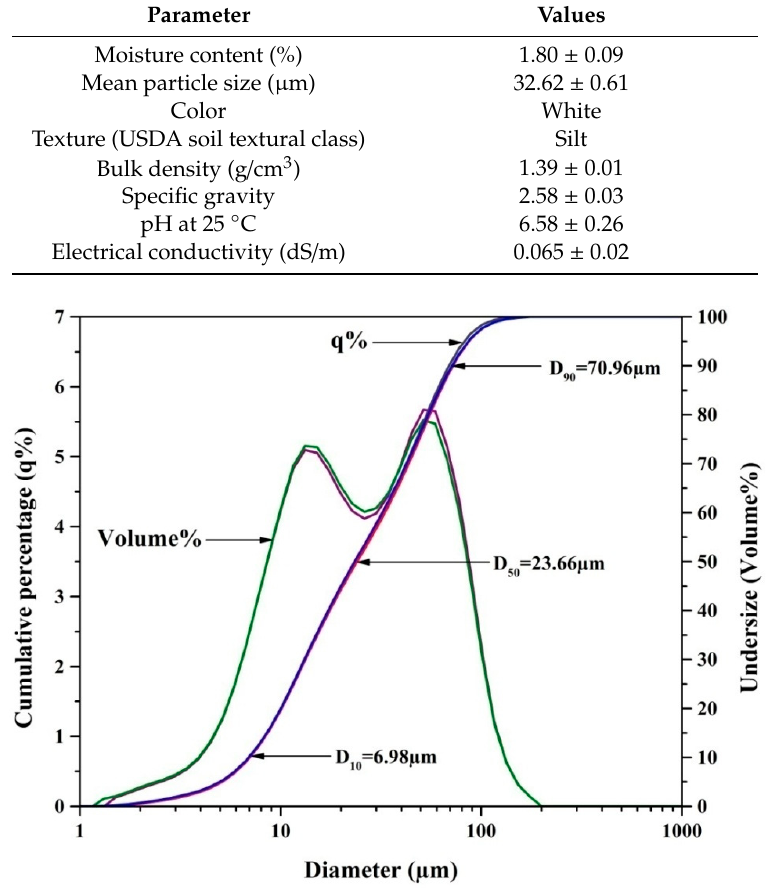
Figure 2. Particle size distribution curve of marble waste particulates.